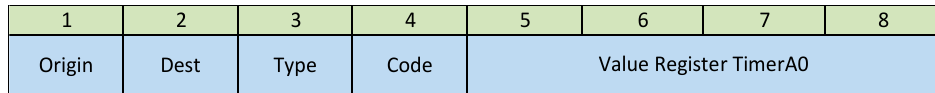
Figure 12. Structure of the Set Timer, Sampling Timer_A0.